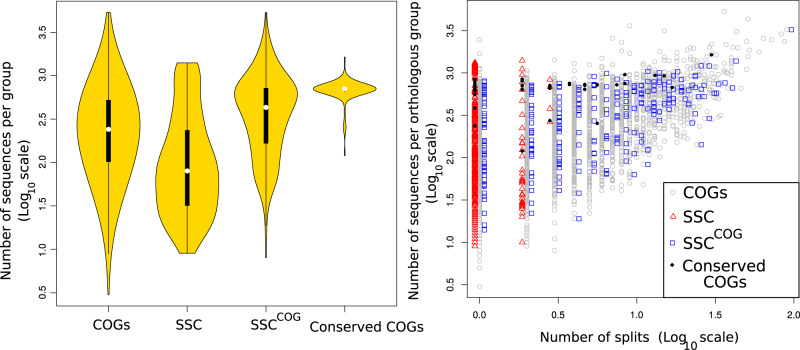
Left: Violin plot depicting the number of sequences per group discussed in the text and table 1. The black bar in the yellow area indicates interquartile ranges. Right: The number of sequences per orthologous group plotted against the number of interdomain branches (splits) found when the sequences are subjected to phylogenetic analysis (log10 scales). Expanding SSCs (red squares) with the complete set of sequences of the corresponding COGs results in SSCCOG (blue triangles).